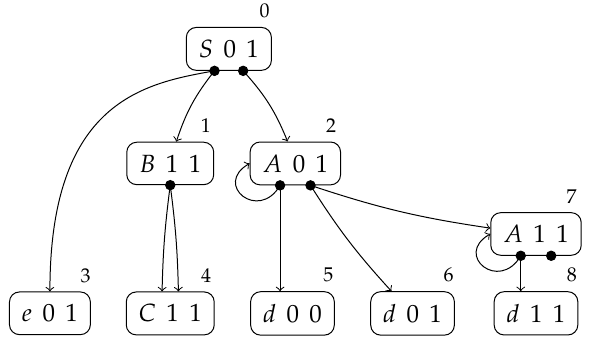
Figure 22. The SPPF for the specification Ξ in (5) and ω “ x